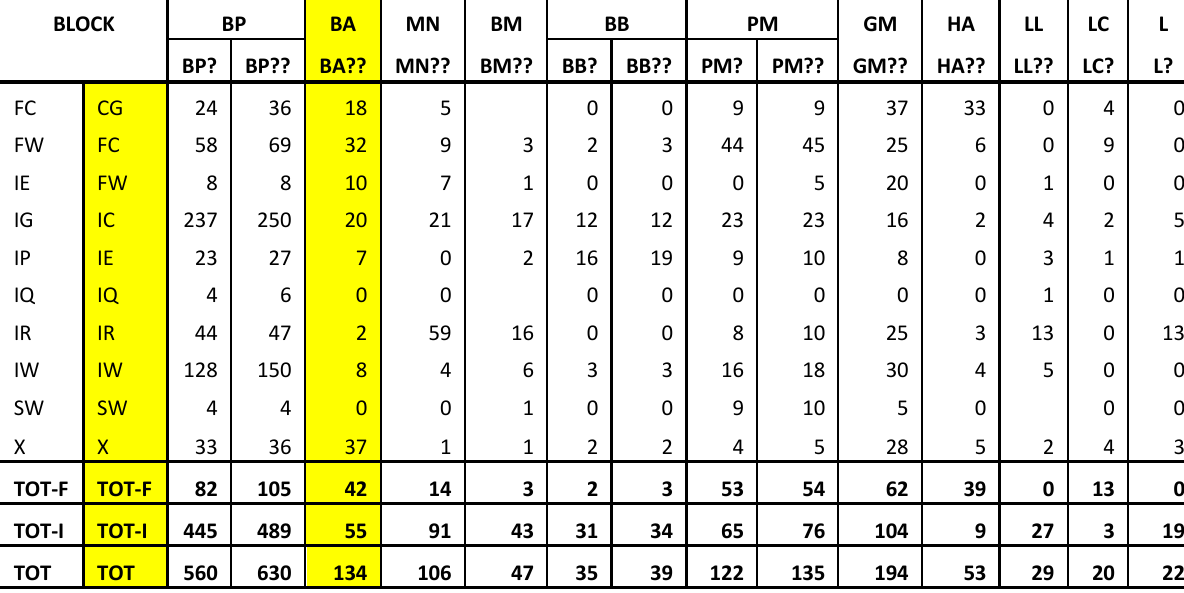
Table 2. Sightings of cetaceans by stratum. Strata used for minke whales are shaded. BP = fin whale, BA=common minke whale; MN = humpback whale, BM = blue whale, BB=sei whale; PM = sperm whale, GM=long-finned pilot whale; HA=northern bottlenose whale; LL = white-beaked dolphin, LC = white-sided dolphin, L? = unidentified Lagenorhynchus dolphin. Number of ? indicates least level of confidence in species identification included in the sum, i.e ? = high + medium, ?? = high + medium + low.